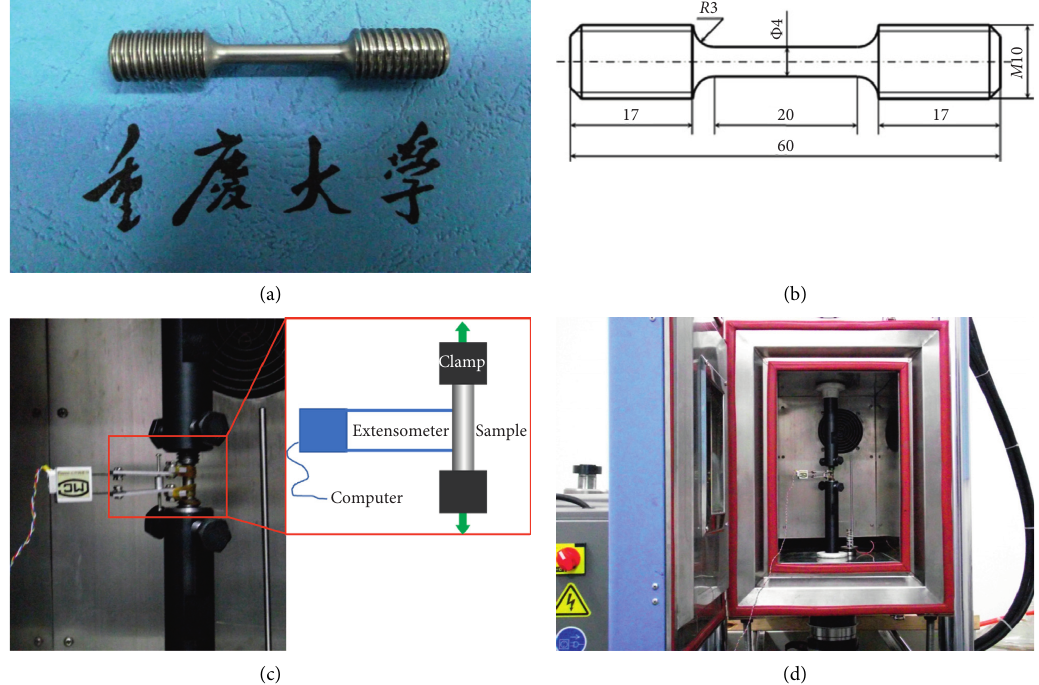
Figure 2: The experimental test: (a) the NiTiNb sample, (b) the size of the sample (mm), (c) the experimental clamping state, and (d) the temperature environment.